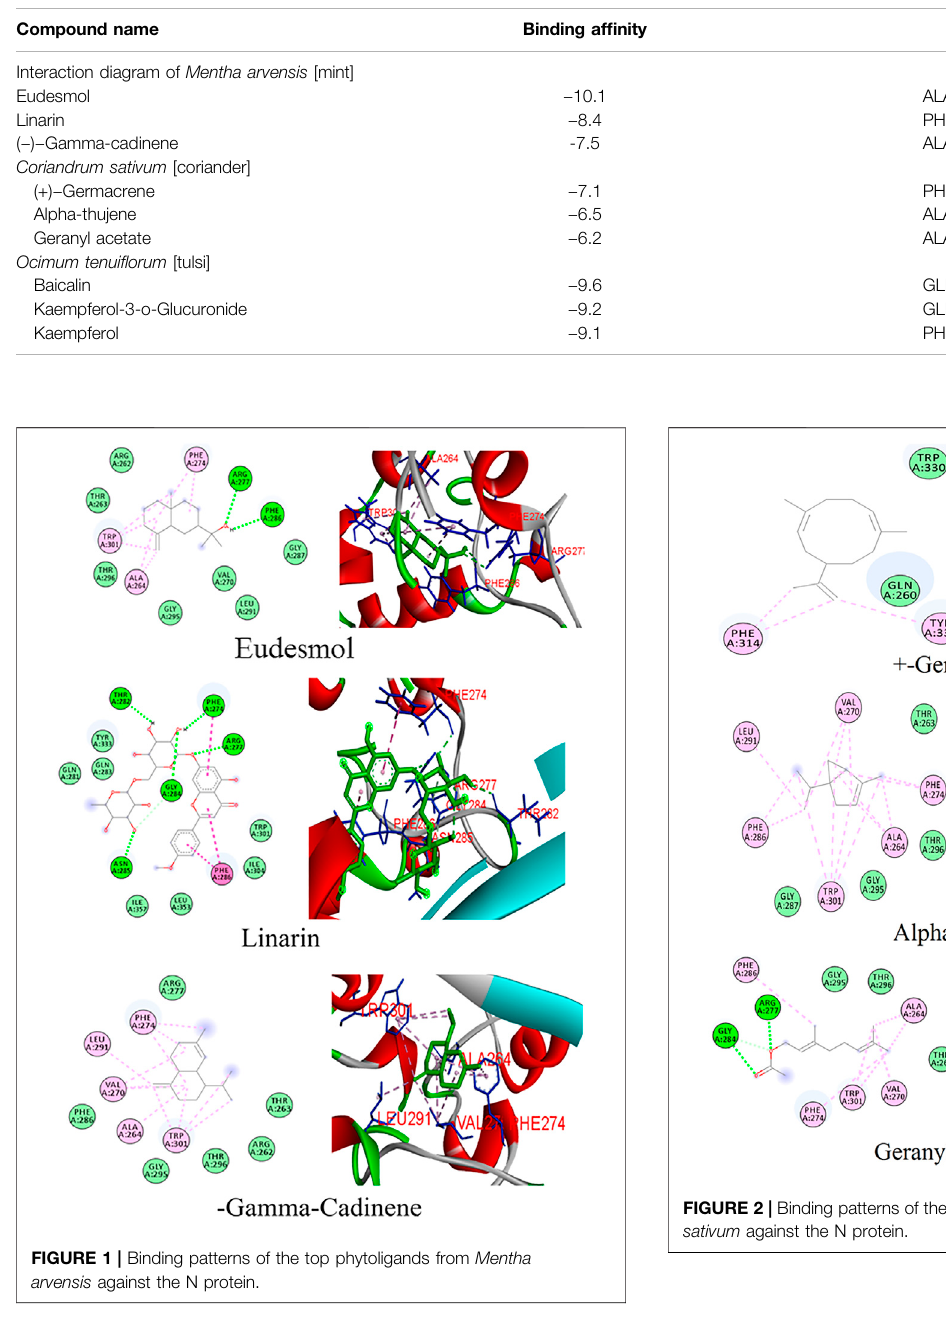
TABLE 1 | List of top three hit phytochemicals from each of the three selected plants ( Mentha arvensis , Coriandrum sativum , and Ocimum tenui fl orum ) along with their binding energy and interaction residues against the N protein as predicted through molecular docking.